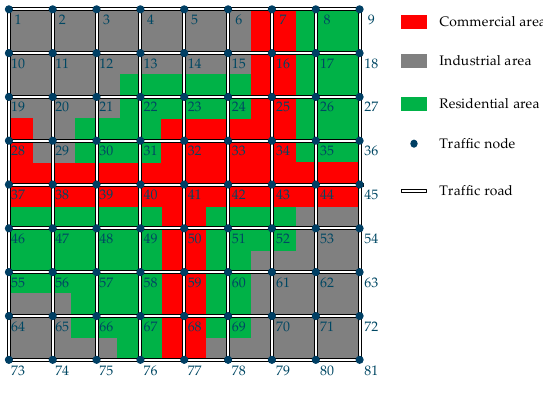
Figure 13. The planning area.